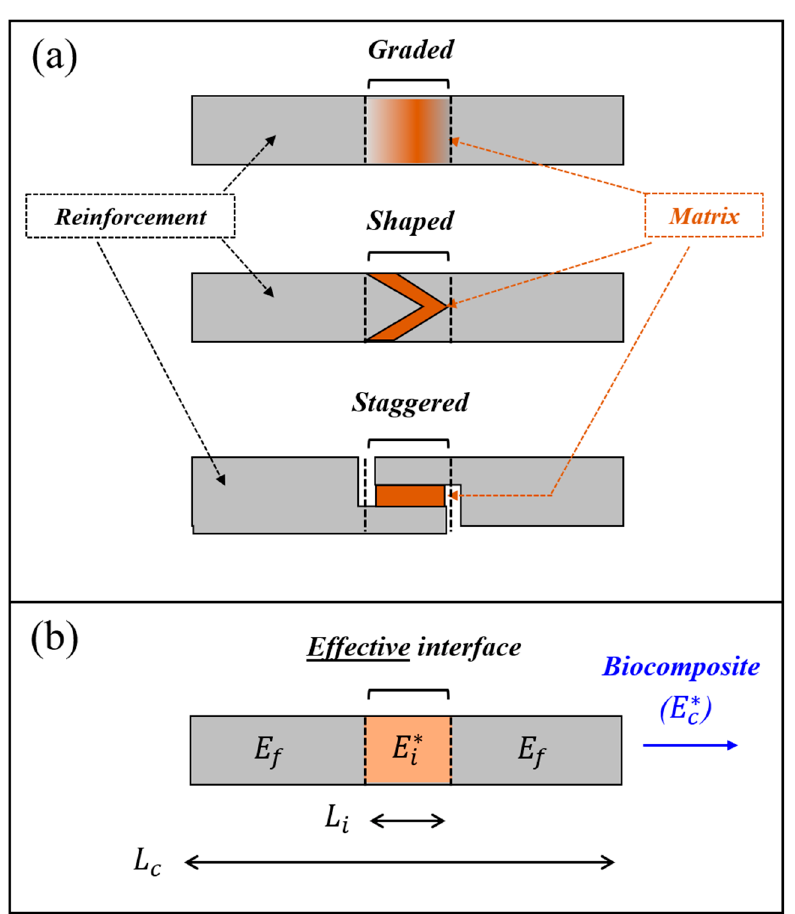
Figure 1. ( a ) Schematic examples of the interfacial regions in biocomposites: graded matrix proper- ties, shaped matrix-reinforcement connection, and staggered matrix-reinforcement connection. ( b ) Mechanical modeling of a biocomposite segment (length (cid:1838) (cid:3030) and dynamic modulus (cid:1831) (cid:3030)∗ ), which includes an effective viscoelastic interface (length (cid:1838) (cid:3036) and dynamic modulus (cid:1831) (cid:3036)∗ ) between adjacent elastic reinforcements (elastic modulus (cid:1831) (cid:3033) ).